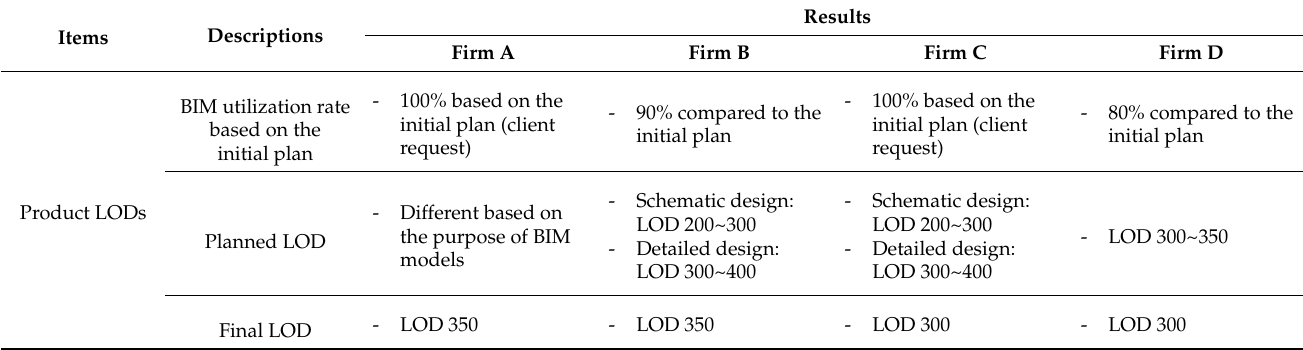
Table 6. Interview results from four different BIM design